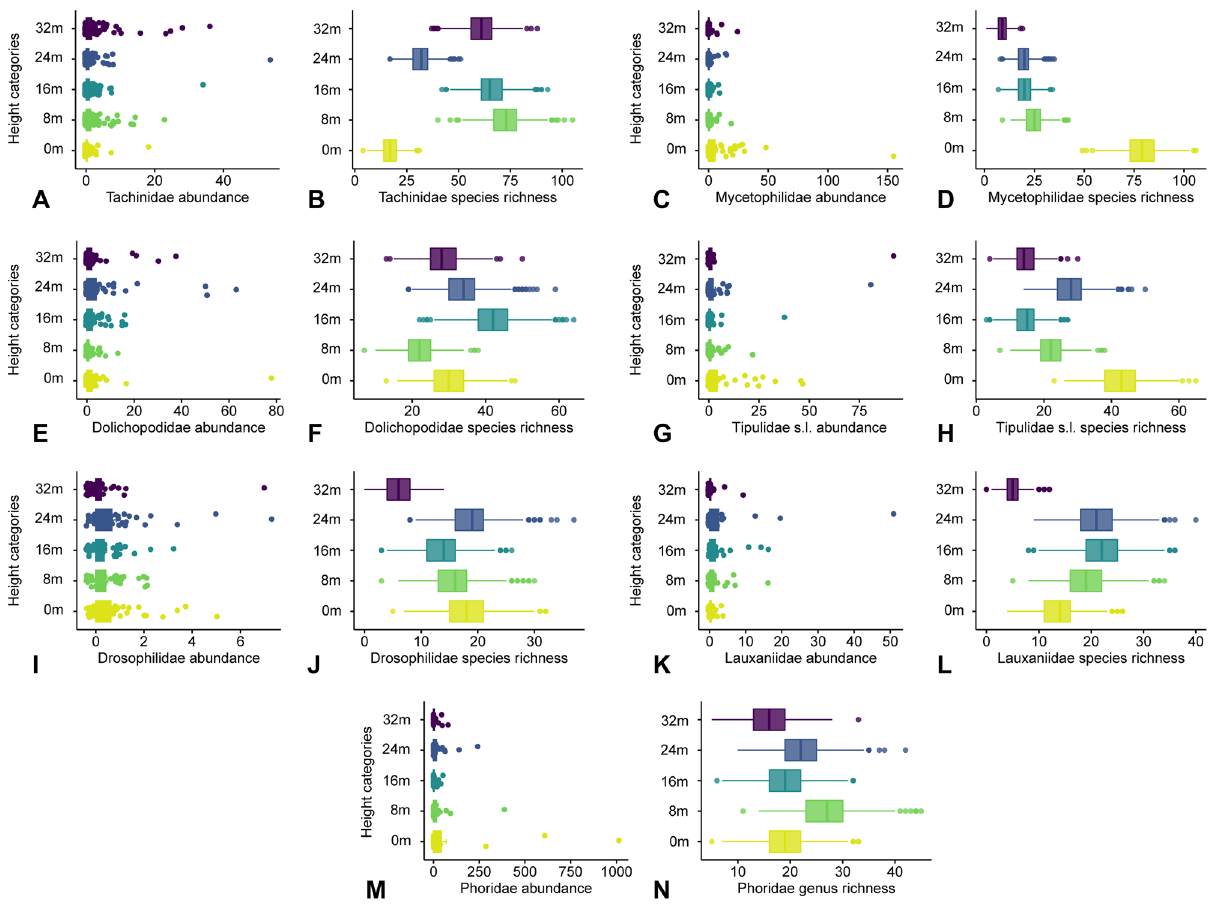
Figure 3. ( A – N ) Vertical distribution patterns of the seven most abundant and/or most speciose Diptera families sampled at the ZF2 tower. ( A , B ) Tachinidae. ( C , D ) Mycetophilidae. ( E , F ) Dolichopodidae. ( G , H ) Tipulidae s.l. ( I , J ) Drosophilidae. ( K , L ) Lauxaniidae. ( M , N ) Phoridae. The abundance box plots are based on the mean counts from the field collection, whereas the species richness boxplots are simulated data based on the total species accumulation of families (or genus for Phoridae) across the canopy